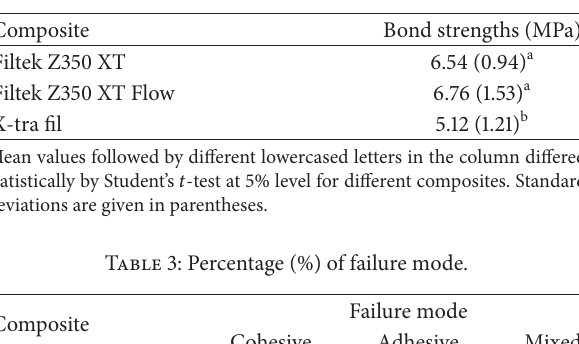
Table 2: Mean of push-out bond strengths (MPa).